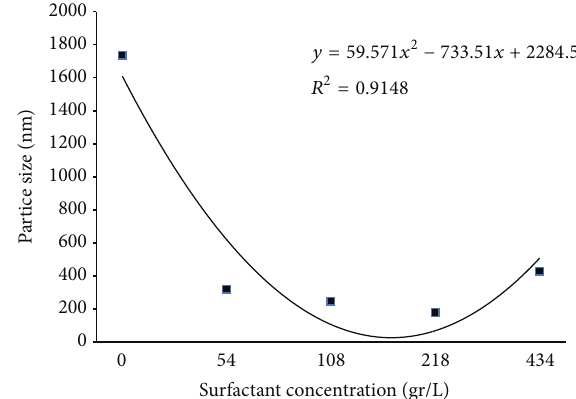
Figure4:TheaverageparticlesizeofsynthesizeFe 3 O 4 particleswith various amounts of surfactant.